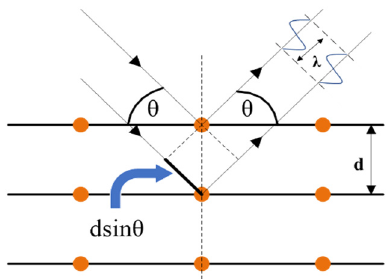
Figure 6. X-ray diffraction principle, where d is the crystal plane spacing, θ is the angle of incidence, and λ is the wavelength of the beam.